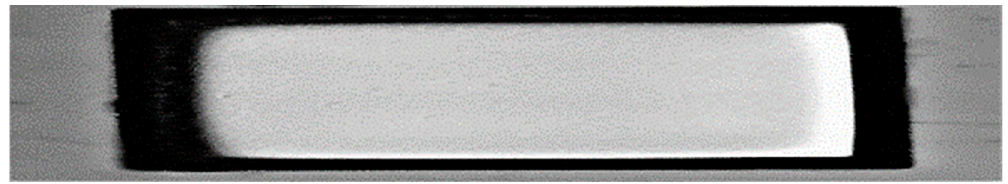
Figure 9. Deep reactive ion etching (DRIE) for structural layer formation.